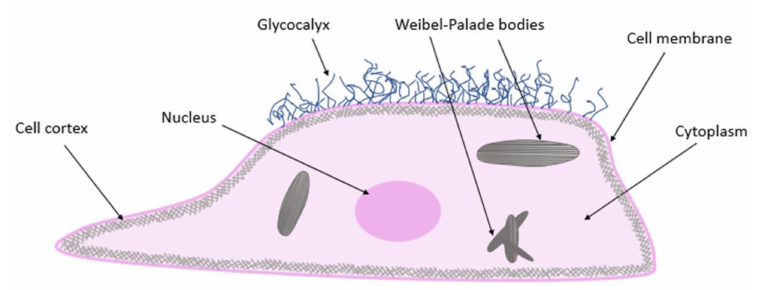
Figure 1. Endothelial cell structure.